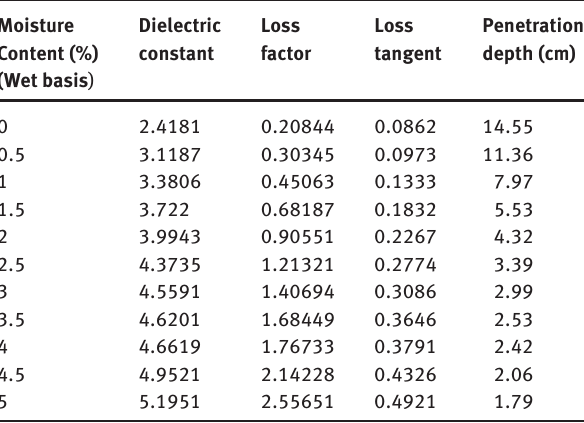
Table 2: The complex permittivity and power penetration depths of sodium chloride particles at different moisture contents at 2.45 GHz